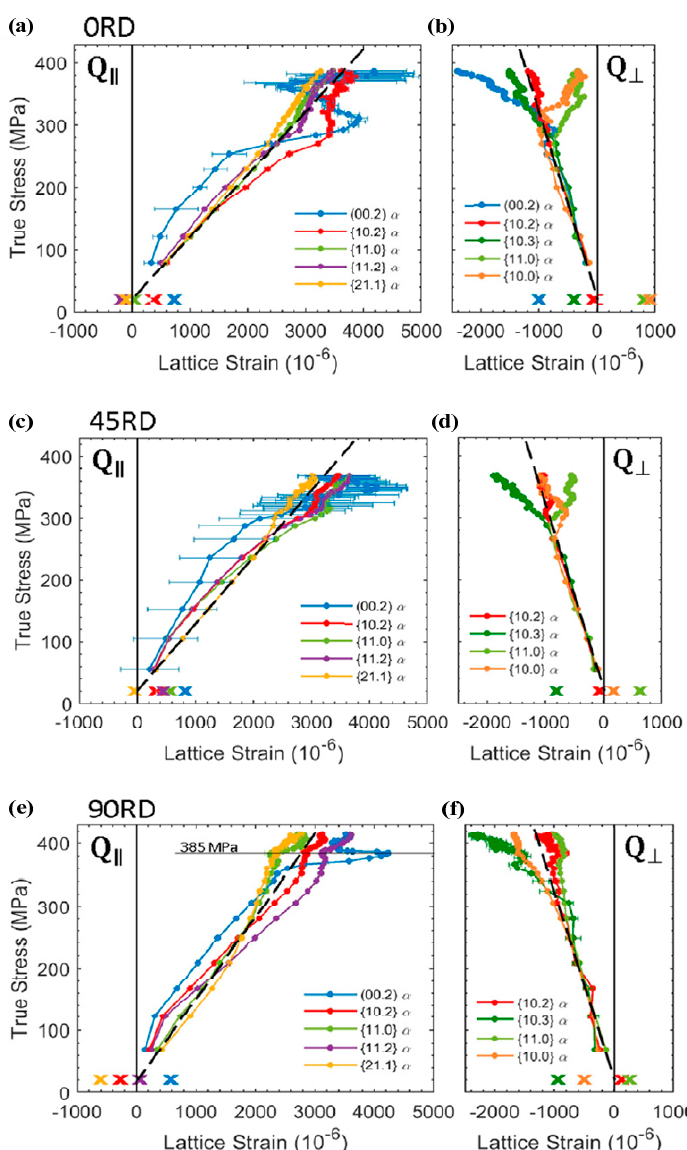
Figure 19. Lattice strain evolution versus applied stress for ( a , b ) 0RD, ( c , d ) 45RD and ( e , f ) 90RD specimens. Selected axial (Q II ) and radial (Q ⊥ ) α -grain families are shown on the left and right, respectively. The unload of the lattice strain is linear for all grain families and is not shown for clarity. The residual lattice strains after unload are marked by “x” [117]. Reprinted with permission from Ref. [117]. Copyright 2019, Acta. Mater.